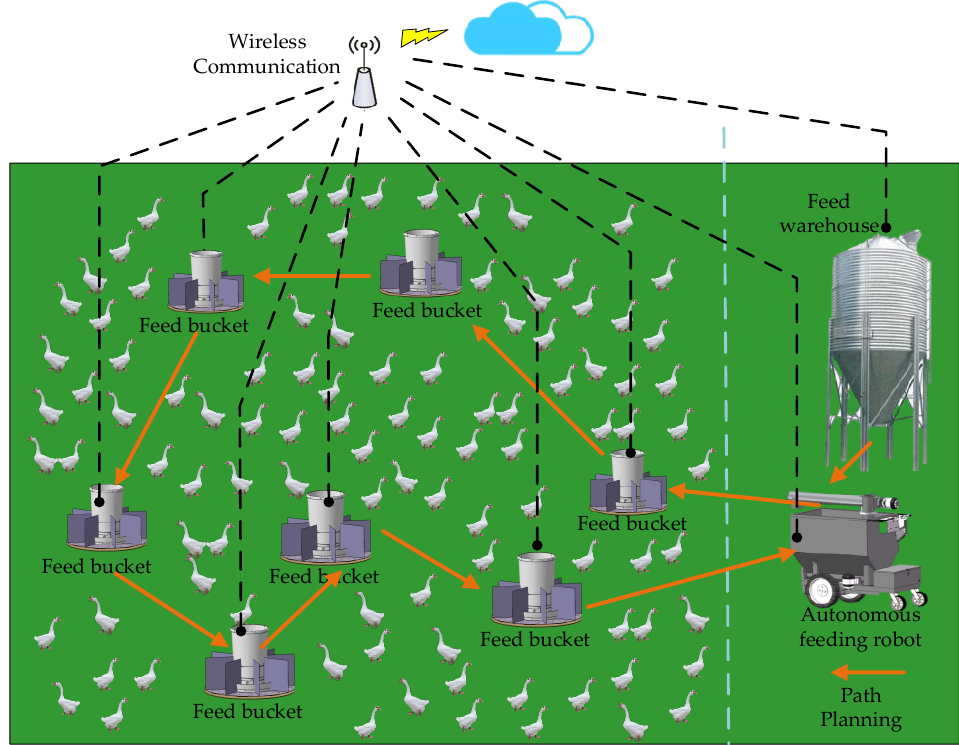
Figure 1. An example of a poultry (goose) smart farm.